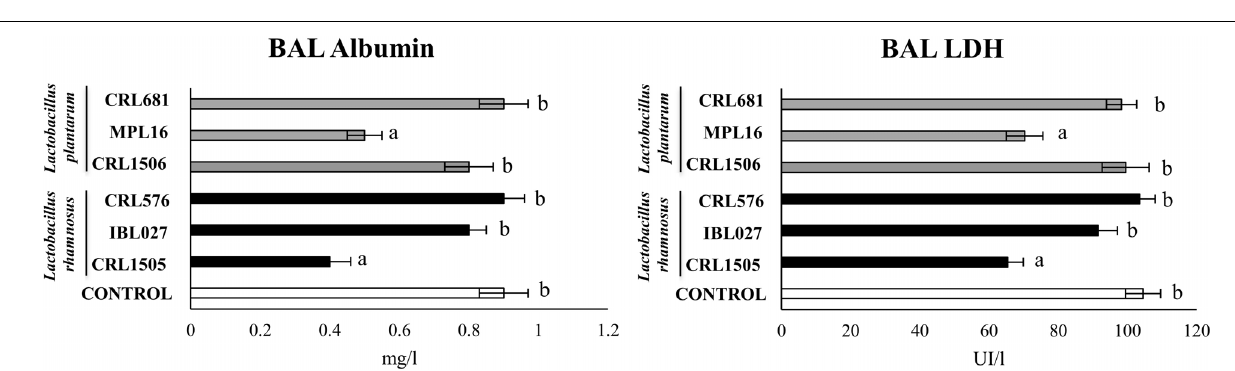
FIGURE 7 | Levels of bronchoalveolar lavage (BAL) injury markers [albumin and lactate dehydrogenase (LDH)] in mice orally treated with Lactobacillus rhamnosus CRL1505, L. rhamnosus IBL027, L. rhamnosus CRL576, Lactobacillus plantarum CRL1506, L. plantarum MPL16, or L. plantarum CRL681 (10 8 cells/mouse per day for five consecutive days) and then challenged by the nasal route with 250 µ g of the viral molecular–associated pattern poly(I:C) for 3 consecutive days. Mice with no lactobacilli treatment and challenged with poly(I:C) were used as controls. Bronchoalveolar lavage injury markers were evaluated on day 2 after the last poly(:C) administration. The results represent data from three independent experiments ( n = 6 per group). Letters indicate significant differences ( P < 0.05), a < b <